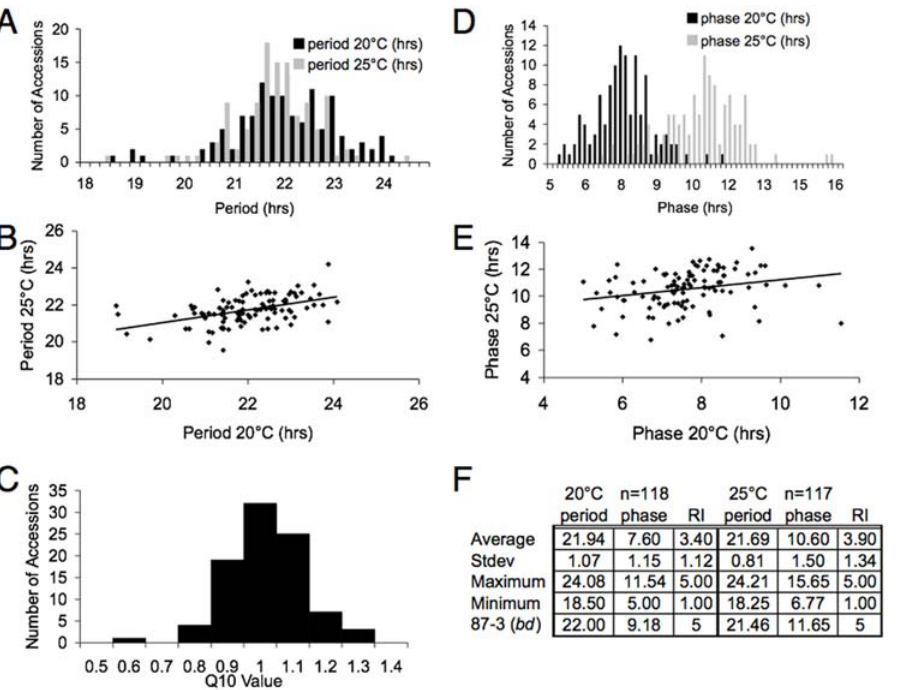
Figure 2. Significant phenotypic variation in period, phase and temperature compensation across 143 N.crassaaccessions. Circadian period (A, B) and phase (D, E) were estimated using the Chrono program for 118 and 117 accessions at 20 u C (grey) and 25 u C (black) respectively that had an average rhythmicity index (RI) $ 3 (Materials and Methods). Period (B), temperature compensation (C) and phase (E) were analyzed for the 106 accessions with a RI $ 3 at both temperatures. Temperature compensation (C) was measured as Q10 (Materials and Methods). (F) Summary of period, phase and RI across the rhythmic accessions at 20 u C and 25 u C. 87-3 is the N. crassa reference accession that harbours the bd mutation and is the primary lab strain. All values presented are an average of four biological replicates (Table S1).